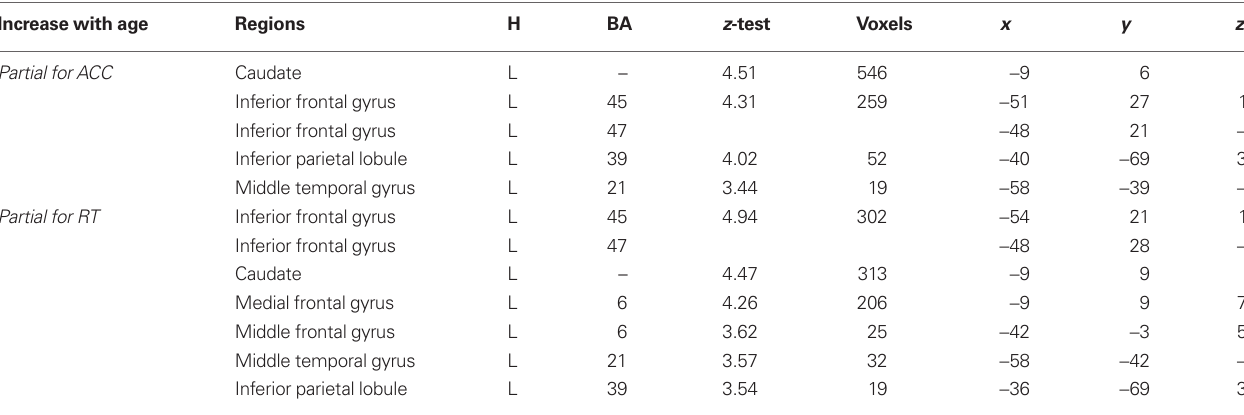
Table 4 | Increasing activation with age for the related pairs compared to the unrelated pairs, partialing out the effect of accuracy (ACC) or reaction time